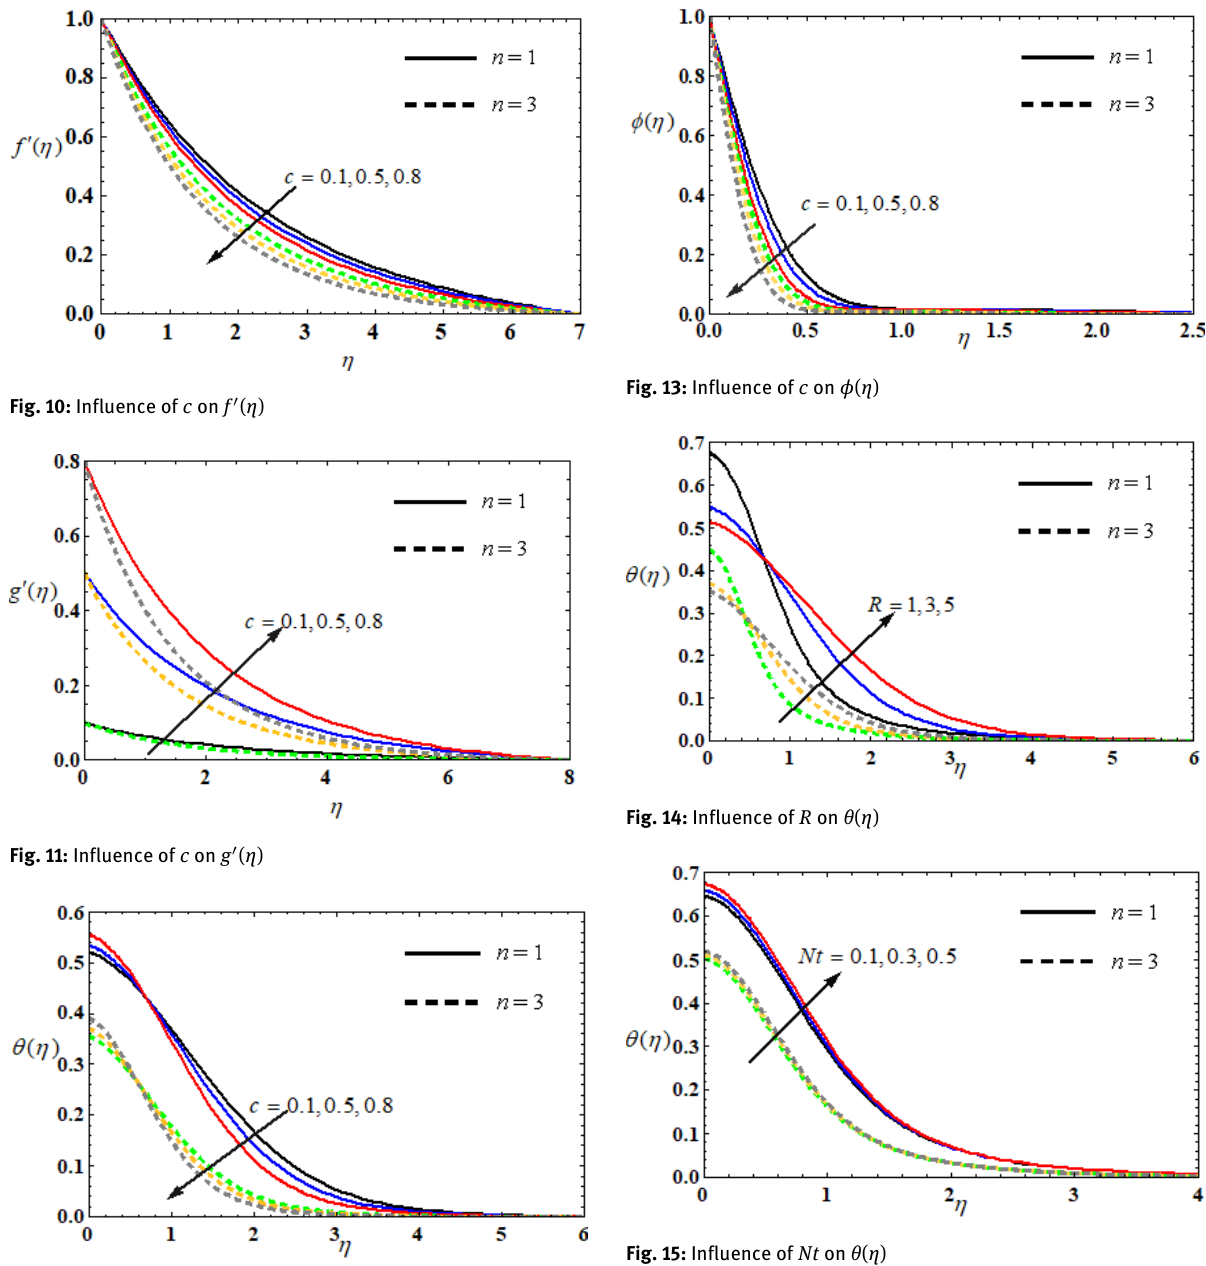
Fig. 12: Influence of c on θ ( η ) an increase in the value of Nt . This is because, if there is a temperature gradient in the flow region of the system, small particles tend to disperse faster in hotter region than in colder region. The collective effect of the differential dis- persion of the particles is their apparent migration from hotter to colder regions. The result of the migration is ac- cumulation of particles and higher particle concentrations in the colder regions of the particulate mixture.